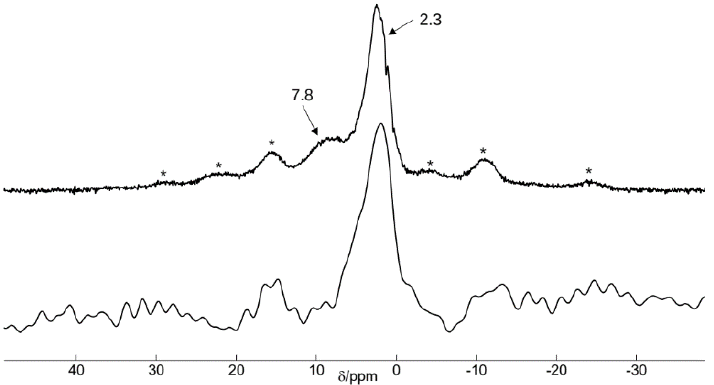
Figure 6. 1 H MAS NMR spectrum of Ba 2 In 1.8 Cr 0.2 O 5.3 (H 2 O) x at a spinning frequency of 10 kHz (top). The bottom spectrum is the result of the double-quantum filter. Spinning sidebands are marked by an asterisk in the top spectrum.